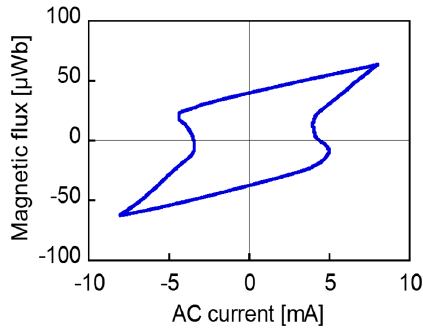
Figure 9. Φ w - I w loop derived from the coil voltage and current wave in Figure 8.